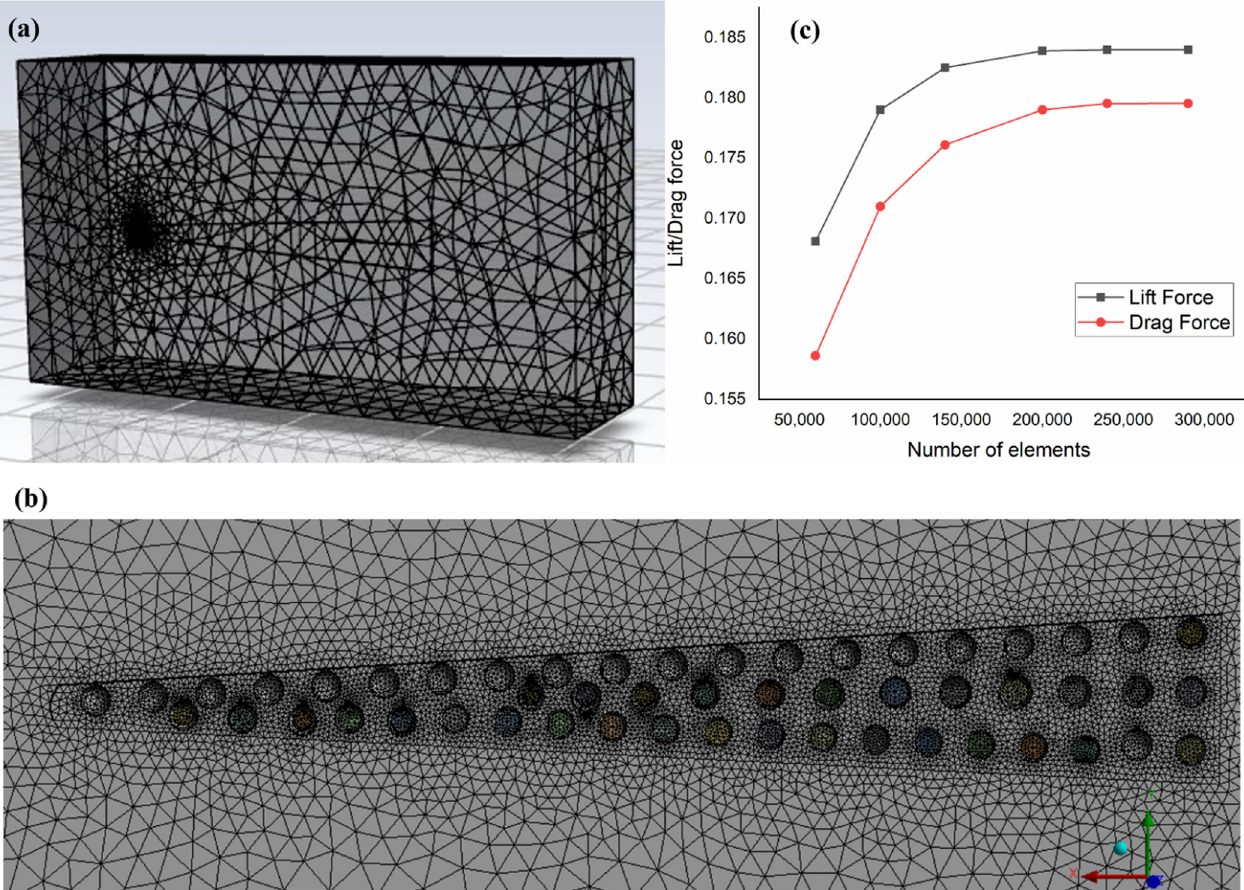
Figure 6. ( a ) Computational domain. ( b ) Mesh diagram of a dimpled section of the turbine blade. ( c ) Mesh independence test for lift and drag.